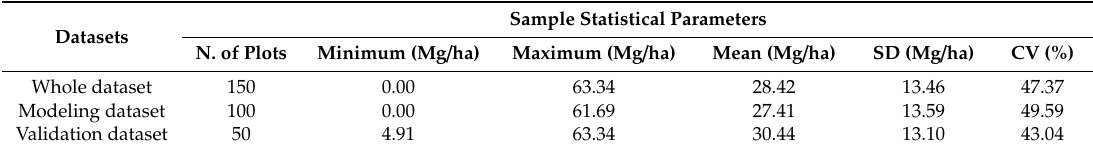
Table 6. Statistical results of the forest carbon density calculated from the sample plots. SD and CV indicate the standard deviation and coe ffi cient of variation, respectively.